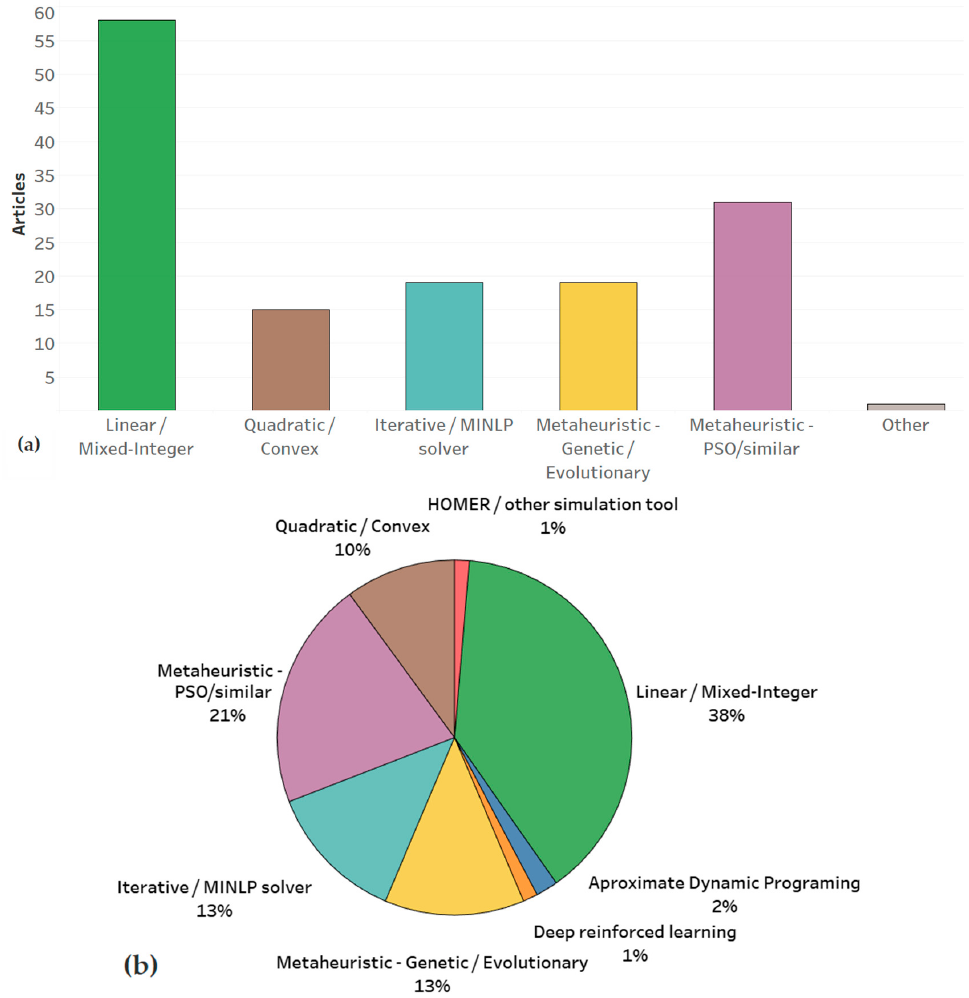
Figure 10. ( a ) Number of articles that use each type of optimization algorithm. ( b ) Share of each type of optimization algorithm in the total number of articles. Table 11. Grid testbeds employed to validate the different